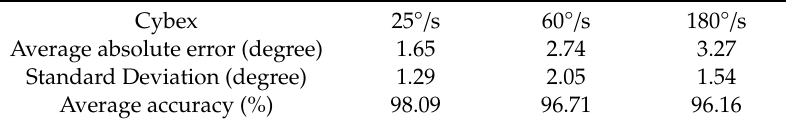
Table 6. Average errors for TKR subjects at three angular